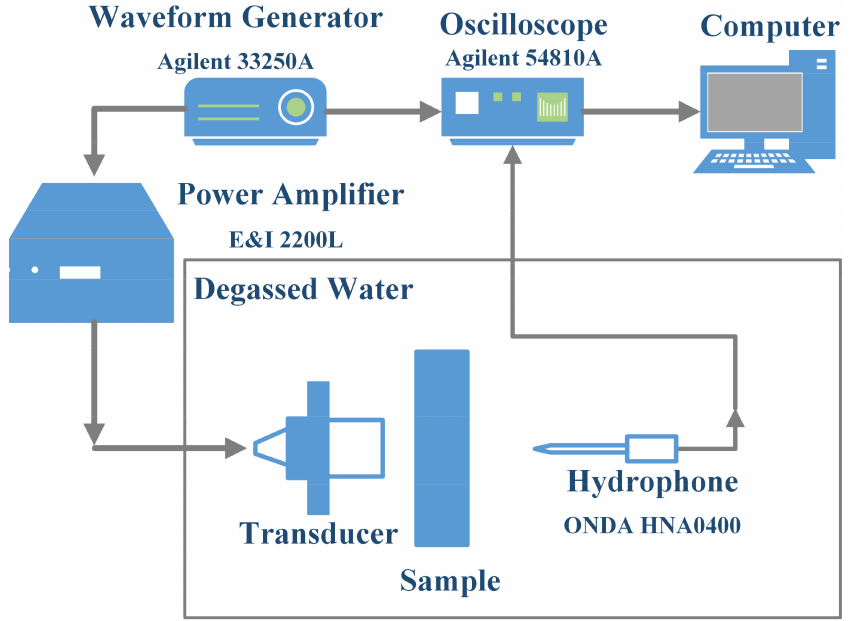
Figure 1. The experimental